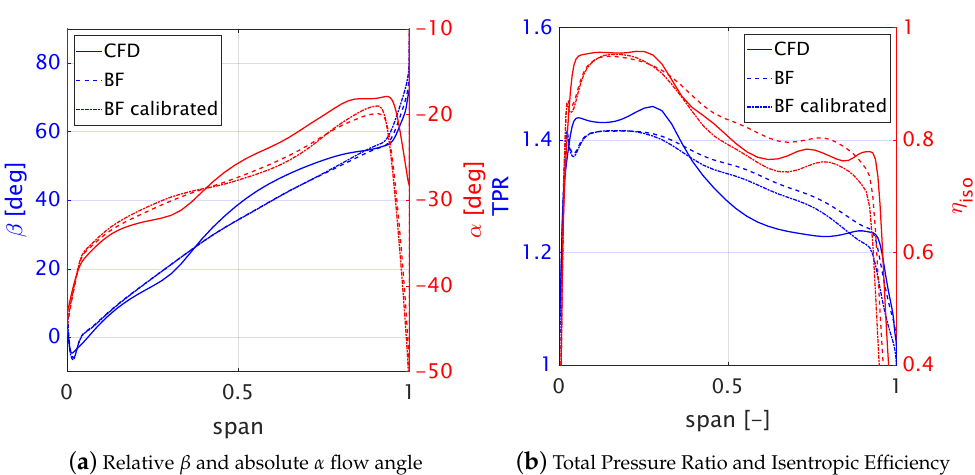
Figure 13. Spanwise distributions downstream of rotor blade at near choke for CFD, baseline, and calibrated body force model.